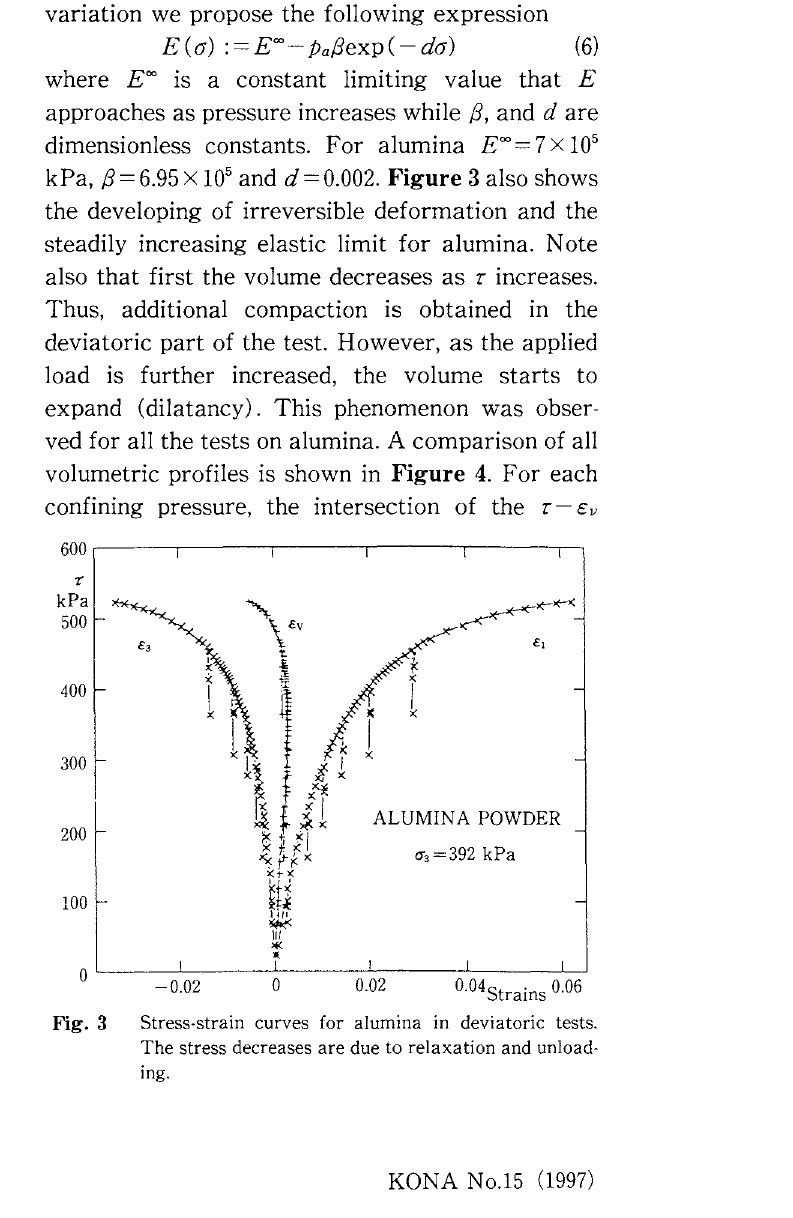
Fig. 3 Stress-strain curves for alumina in deviatoric tests. The stress decreases are due to relaxation and unload